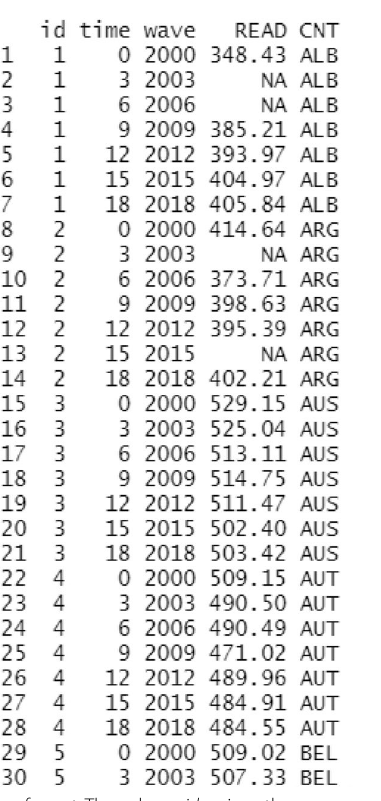
contained in the time